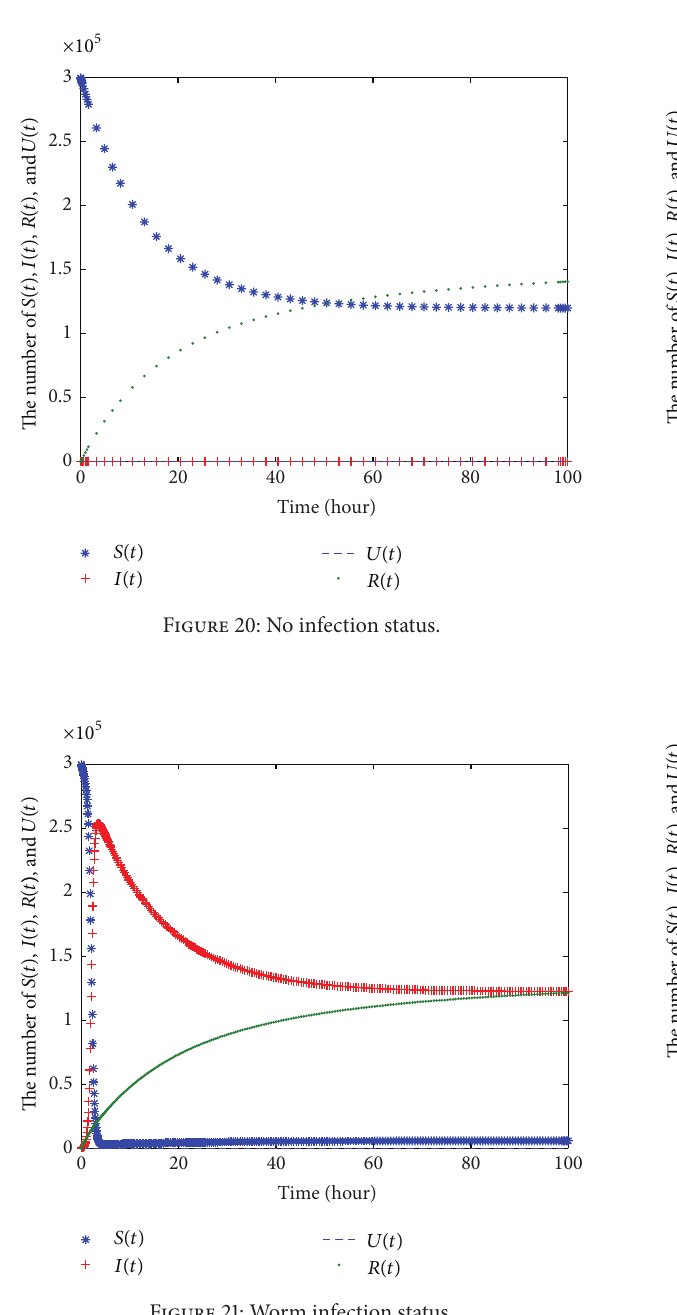
Figure 21: Worm infection status.